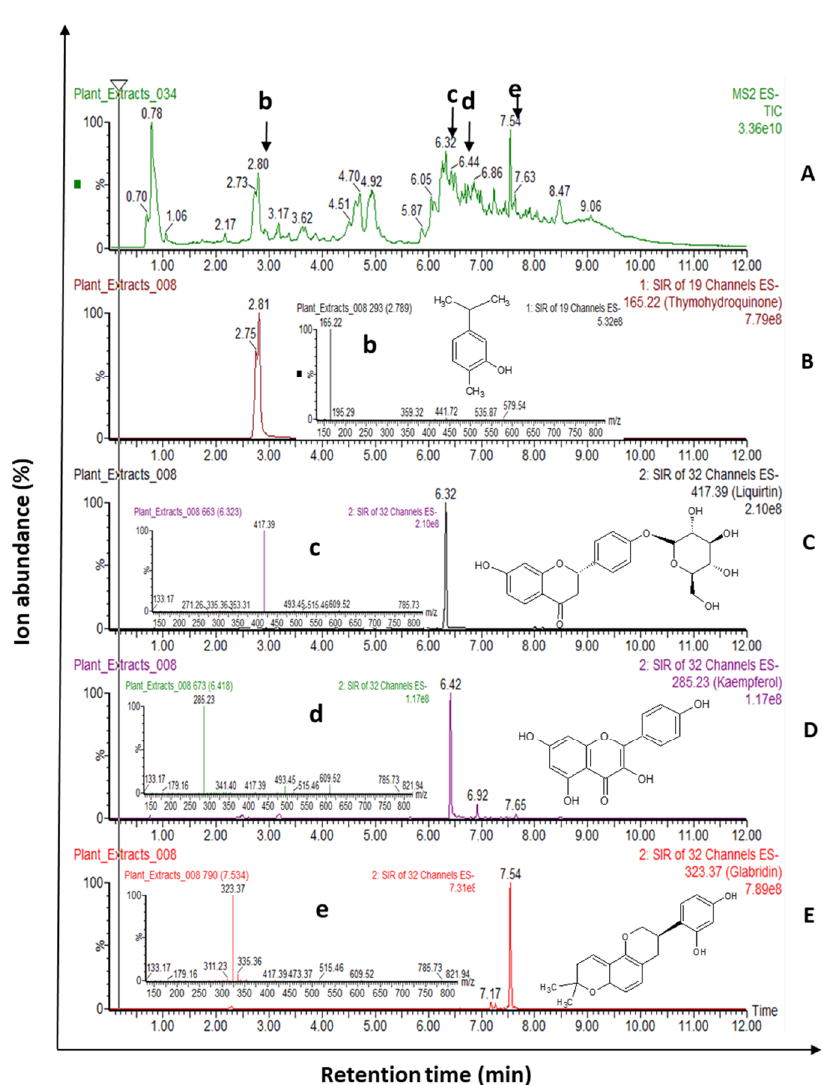
Figure 1. The full scan mode total ion chromatogram of licorice root hot water infusion from a negative mode of UPLC-ESI-MS / MS analysis ( A ). The SIM channels ( B – E ) and mass spectra of the full-scan of selected four major phytochemicals; thymohydroquinone (b), liquiritin (c), kaemferol (d), and glabridin (e) are shown for m / z of deprotonated ions of 165.22, 417.39, 285.23, and 323.97, respectively. The identified phytochemical name and chemical structure are presented. SIM: Selective ion monitoring scan; TIC: Total ion chromatograms, UPLC-ESI-MS / MS: Ultra-performance liquid chromatographic-electrospray ionization-tandem mass spectrometry.